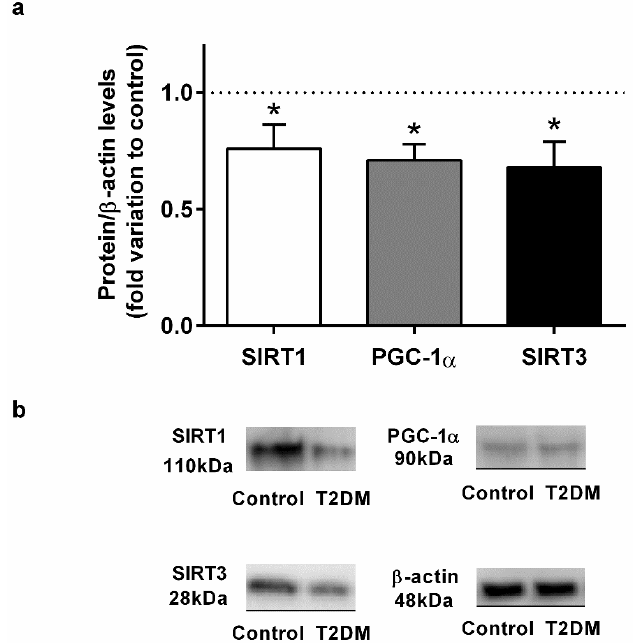
Figure 2. ( a ) Effect of type 2 diabetes mellitus in epididymal proteins levels of Sirtuin 1 (SIRT1), peroxisome proliferator-activated receptor coactivator 1 α (PGC-1 α ), and Sirtuin 3 (SIRT3). ( b ) Representation of an illustrative Western blot experiment for the epididymis tissue of the control and type 2 diabetic animals (T2DM). Number of animals per group: 7 in control group and 7 in T2DM group. Results are presented as mean ± SEM of three independent experiments. Significantly different results ( p < 0.05) are indicated: * relative to control. 2.3. Expression of the Epididymal Mitochondrial Complexes II, III, and V was Affected by T2DM T2DM significantly decreased the expression of the mitochondrial complex II, from a 1.00 ± 0.12-fold variation in the epididymis of rats from the control group to a 0.76 ± 0.09-